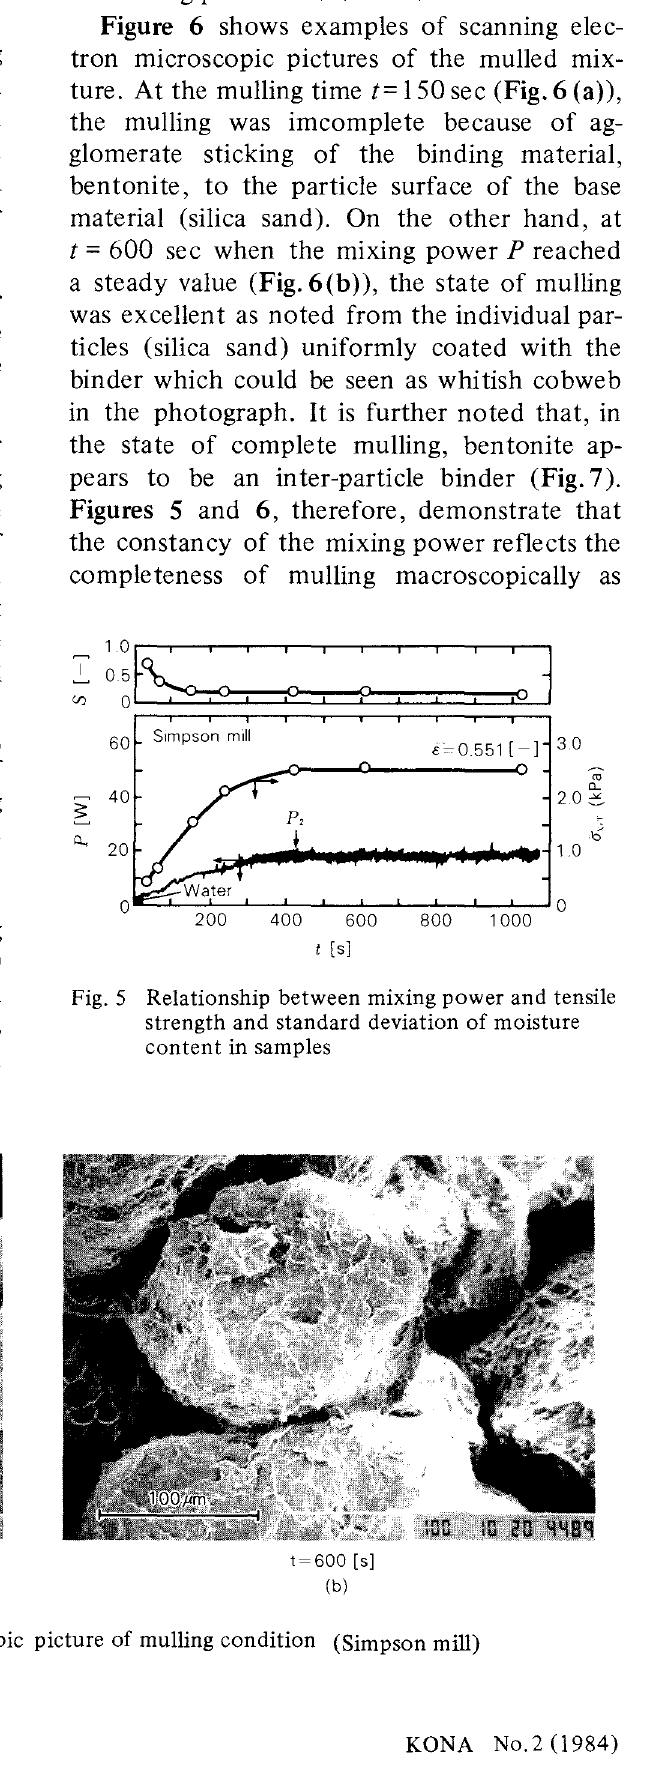
Fig. 6 Scanning electron microscopic picture of mulling condition (Simpson